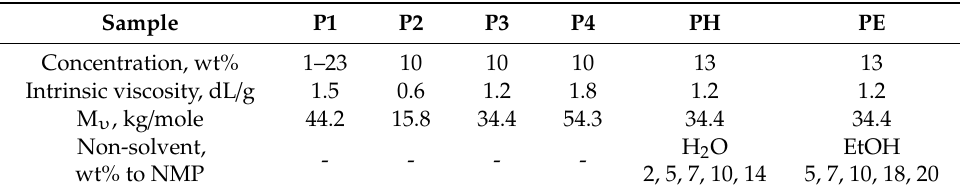
Table 1. Samples abbreviations and